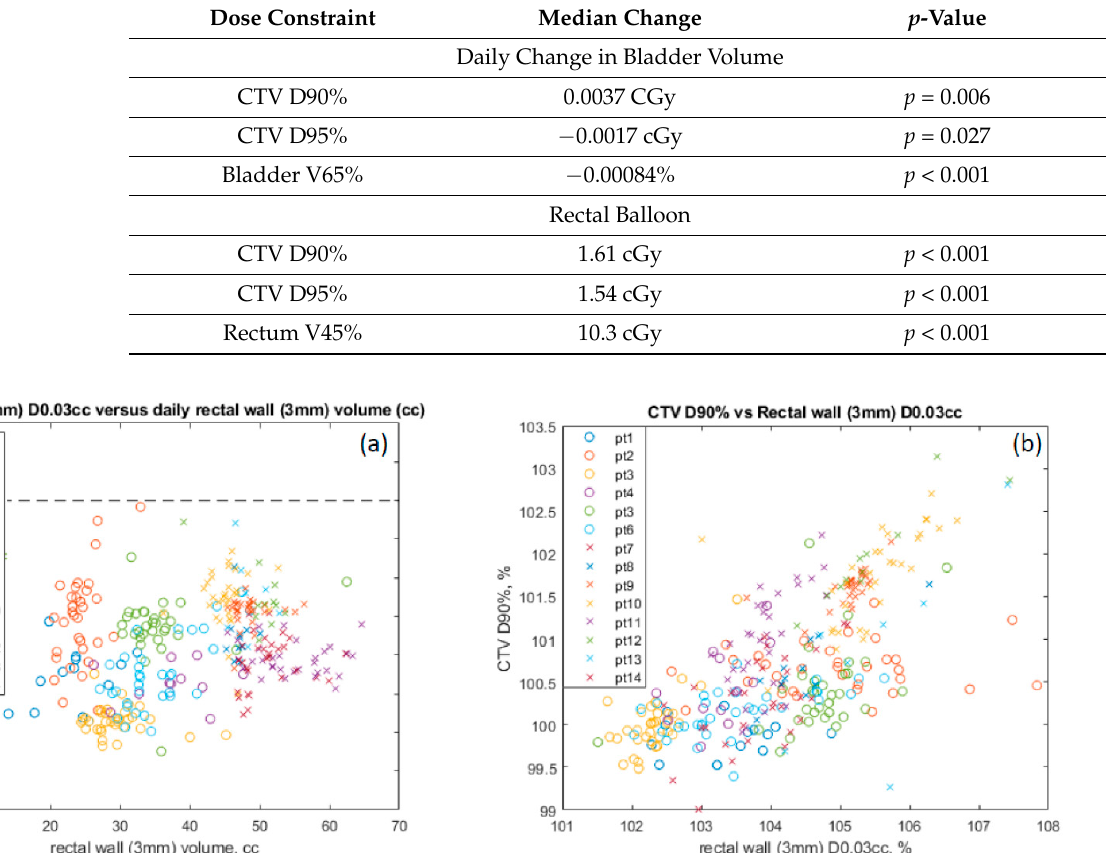
Table 1. Impact of Bladder Filling Change and Rectal Balloon on Target Coverage and Organs at Risk.